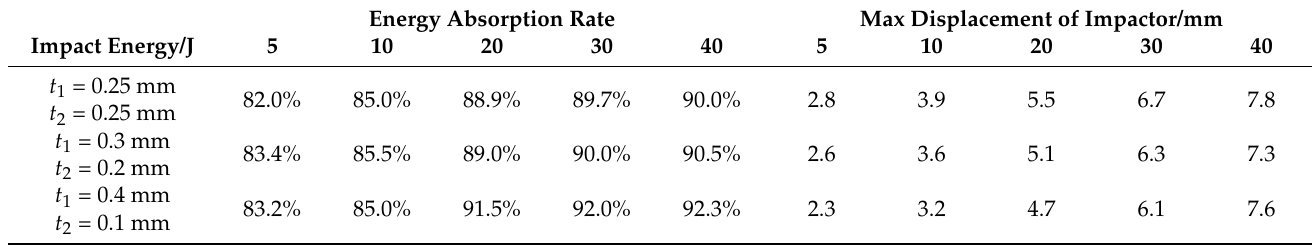
Table 8. Comparison of low-velocity impact resistance of double-layer structures with different wall